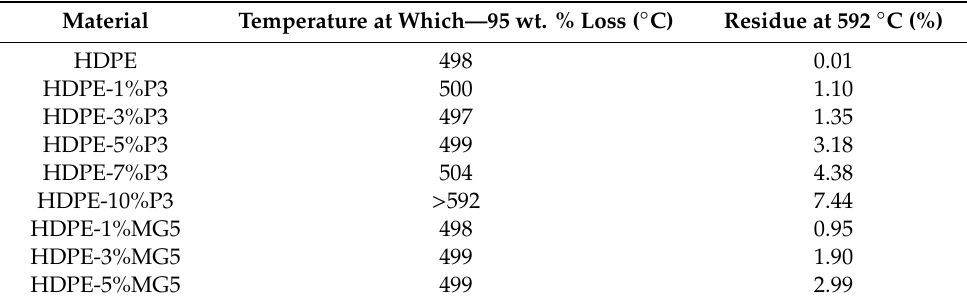
Table 4. TGAs data of HDPE, P3 and MG5 composites.